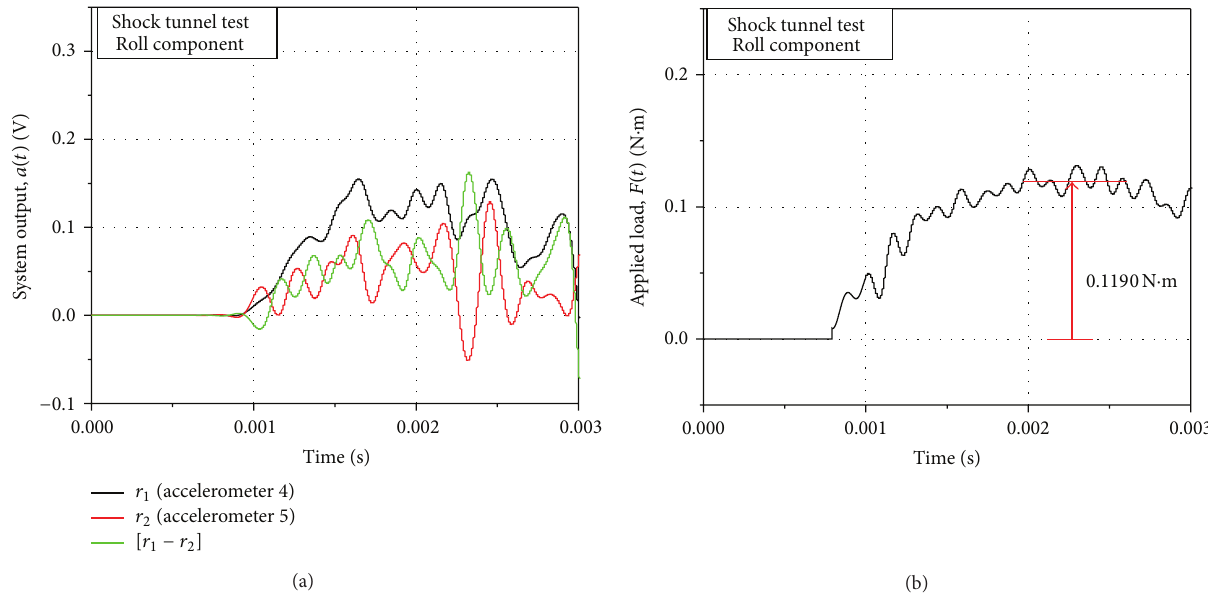
Figure 7: (a) System output and (b) deconvoluted applied load for rolling component for aerodynamic test in shock tunnel. Model AOA = 10 ∘ .